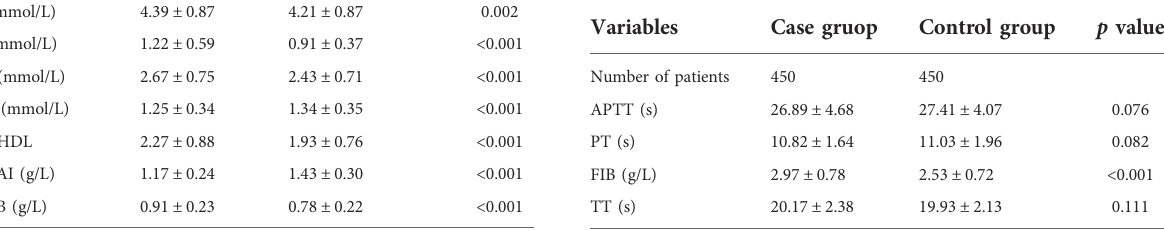
TABLE 4 Comparison of four coagulation indicators between groups.